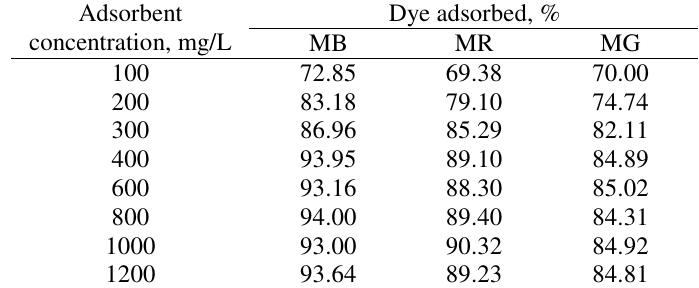
Table 2. Effect of adsorbent dosage on biosorption of dyes (dye concentration: 100 mg/L; contact time: 3 h; pH: 6.0).